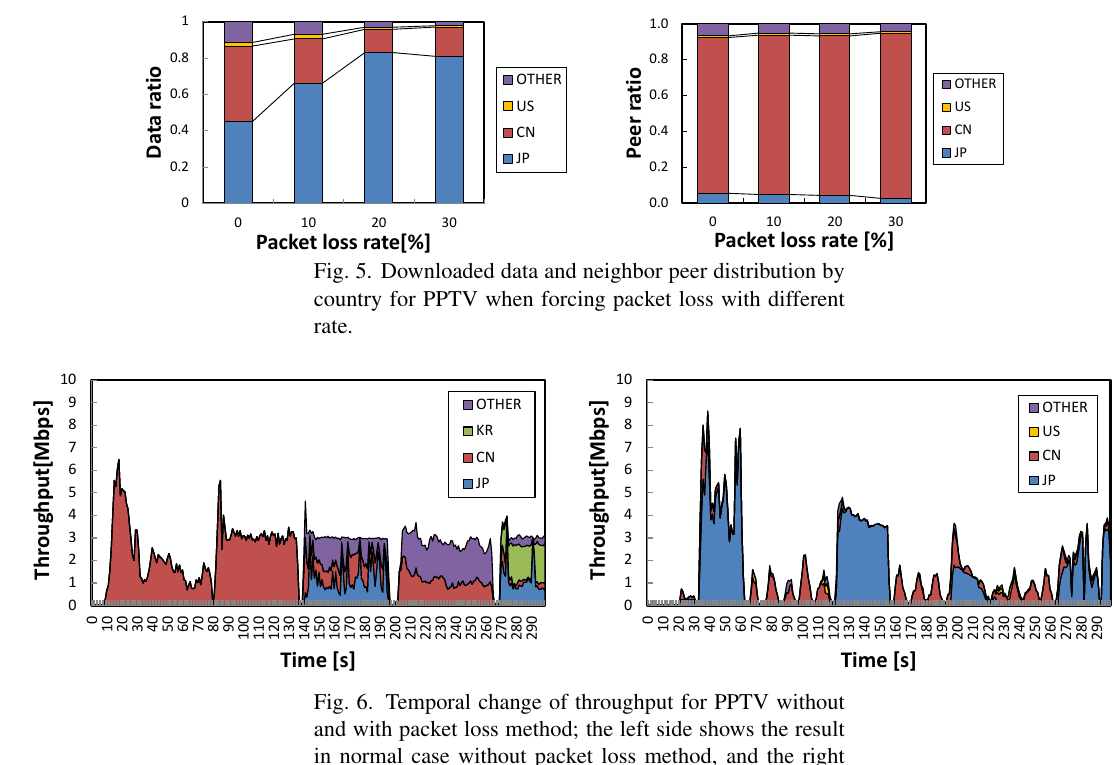
Fig. 6. Temporal change of throughput for PPTV without and with packet loss method; the left side shows the result in normal case without packet loss method, and the right side shows the result when forcing 20% packet loss to over- seas